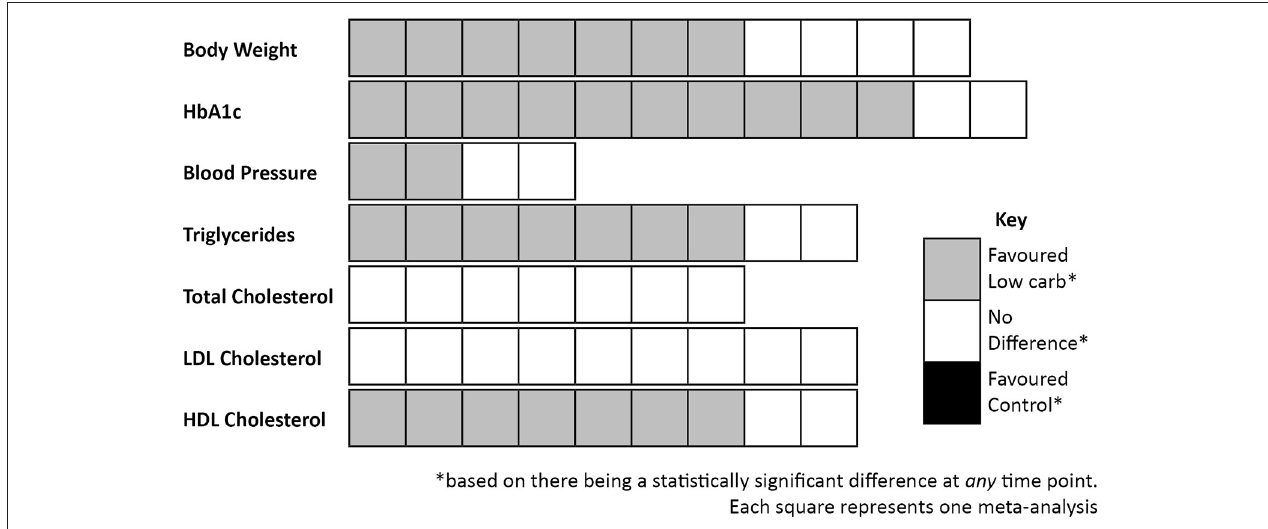
FIGURE 3 | Summary of outcomes from meta-analyses that compared low carbohydrate dietary approaches with control diets in people with Type 2